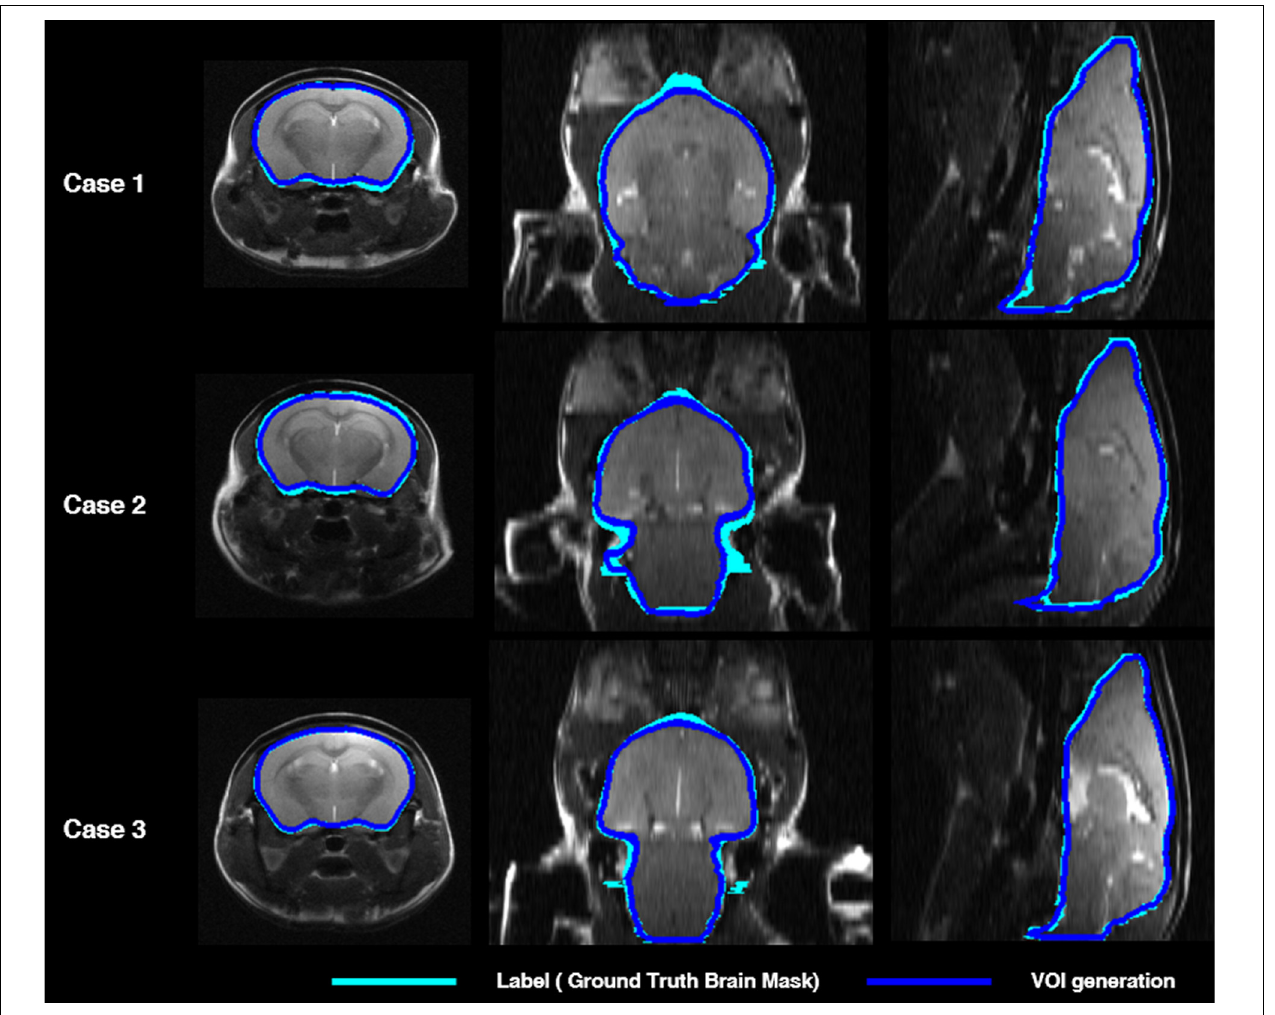
FIGURE 2 | Comparison of mouse brain parenchyma mask contours between manually traced brain mask (light blue) and deep CNN-predicted brain mask (blue) in three cases. The left shows the axial plane, the middle the coronal plane, and the right shows the sagittal plane. deep CNN, deep convolutional neural network.